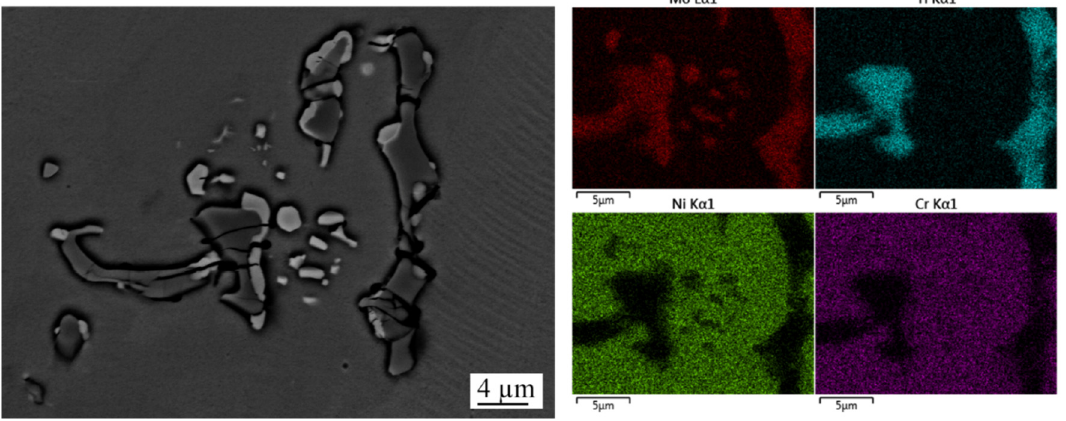
Figure 5. SEM energy-dispersive X-ray spectroscopy (EDS) maps showing segregation of